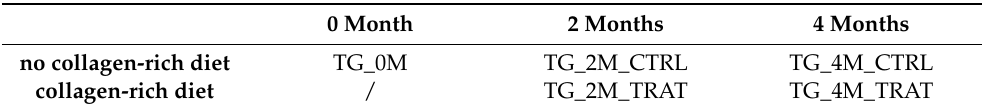
Table 1. Fish skins from animals fed with and without collagen-rich feed (supplementation) for 0, 2, and 4 months are